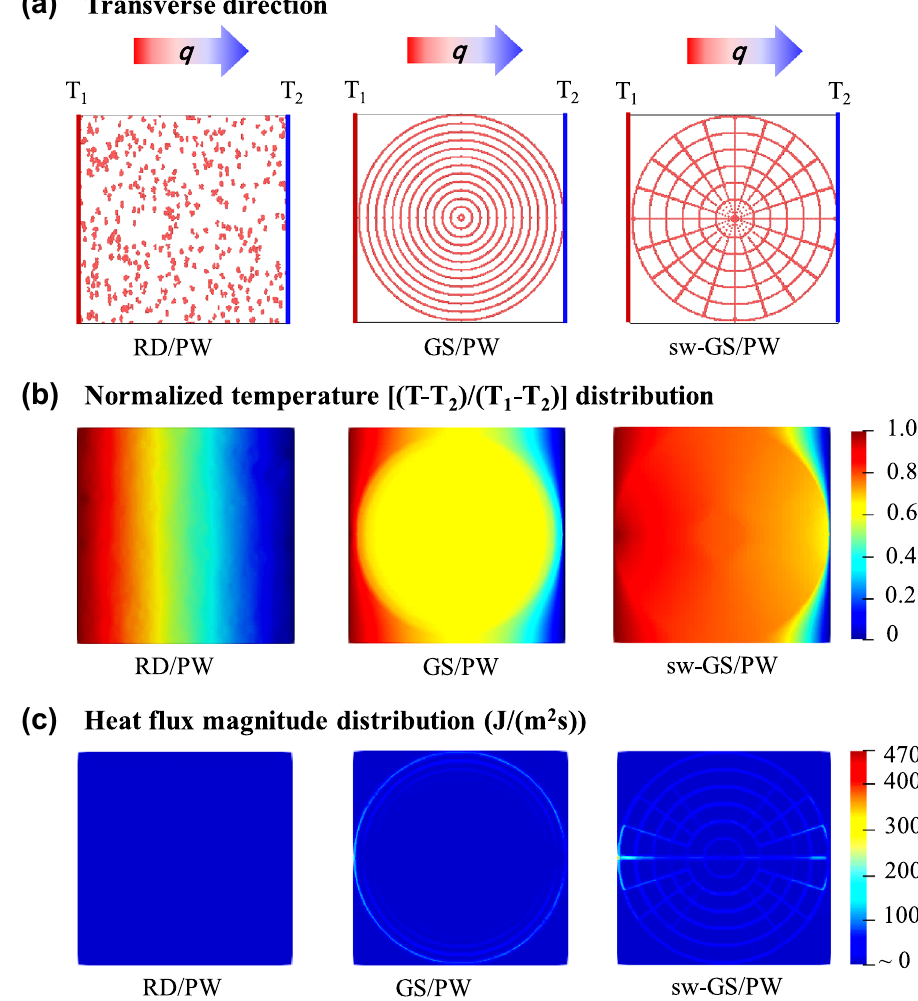
Fig. 5 a FE simulation for three PCCs. The red (blue) line in the left (right) of the PCCs can be considered a heat source (heat sink). b Simu‑ lated normalized temperature distribution and c heat flux magnitude distribution of nanocomposites based on a heat source and a heat